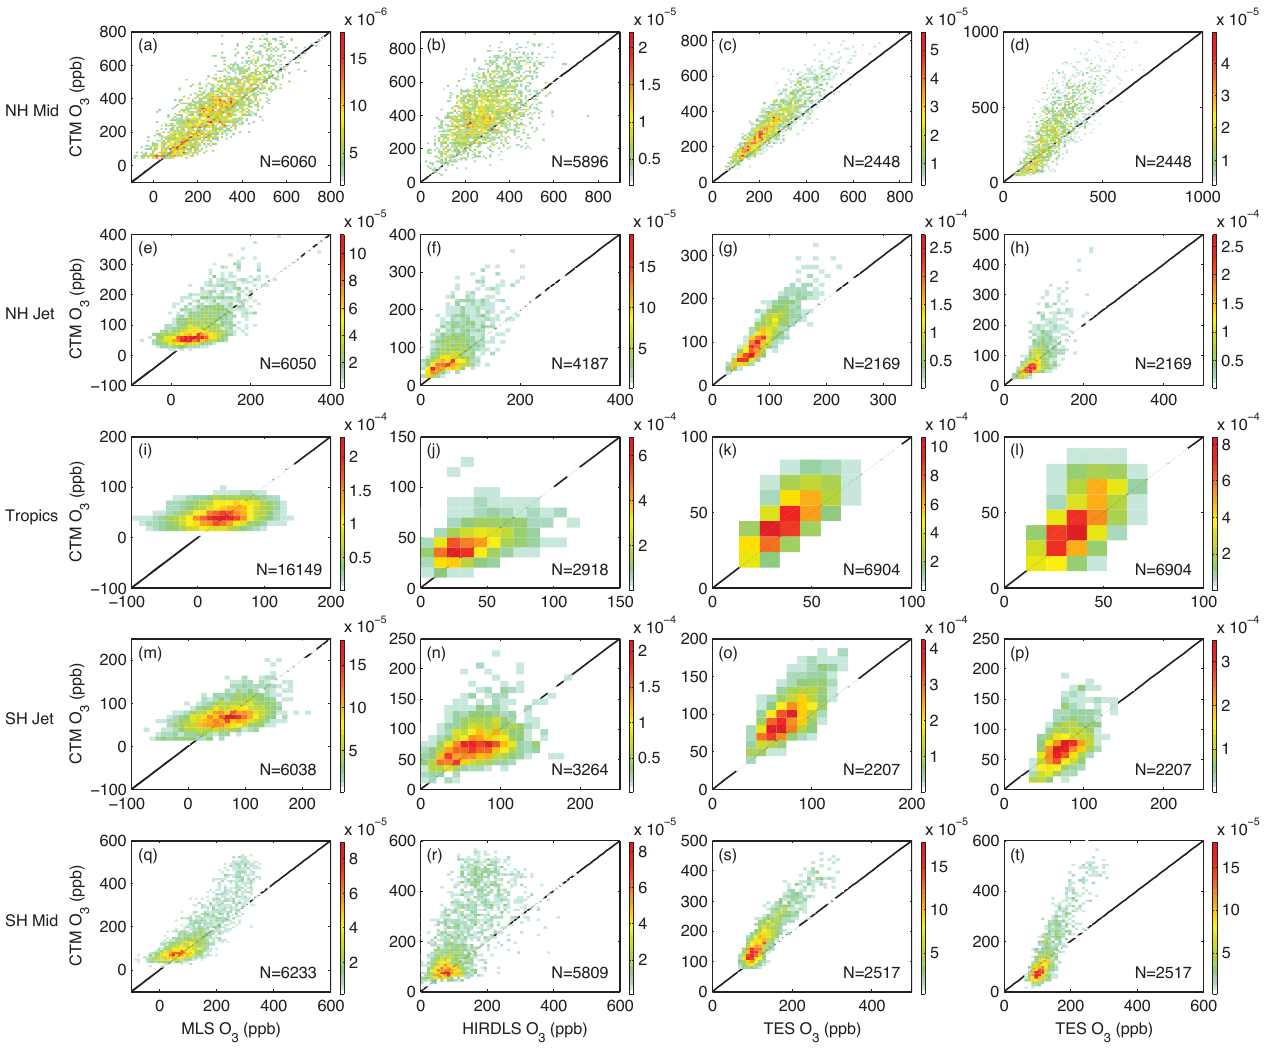
Fig. 7. Same as Fig. 5 for January 2006 at 215hPa. The mean biases and RMS are given in Table 3.